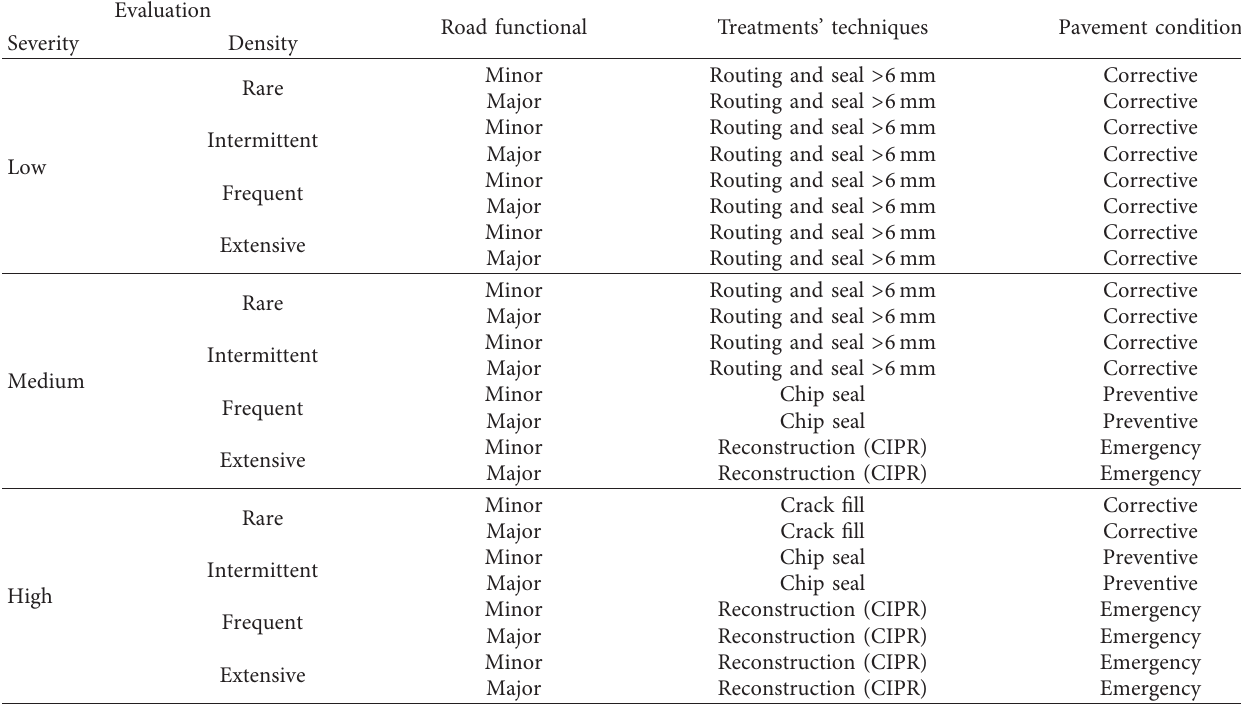
Table 3: Criteria for the maintenance of transverse cracking.